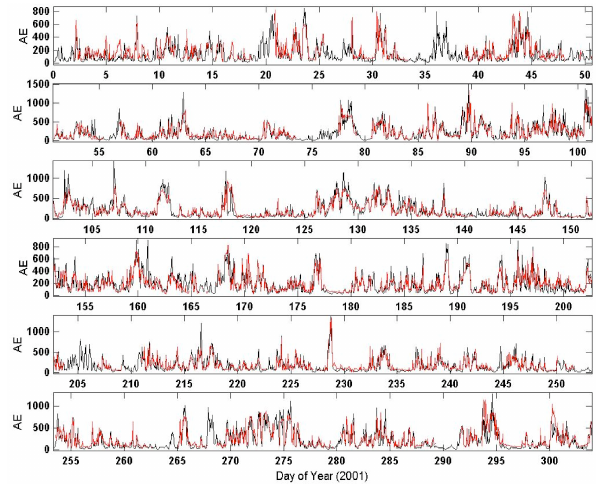
Figure 10. Fig. 10. The AE index values as a function of time in 10 months of 2001 are specified by their corresponding driver states, in ac- cordance with the magnetospheric state prescription of Eqs. (5) and (6). Magnetospheric states are specified by the driver and response parameter data obtained in 1970–2000, with V sw (E0), B z (E1), P sw (E0), and B tot (E0) having been localized. The esti- mation error is ± 111.8nT (consistent with Fig. 6b) and correlation factor with the actual data is 0.826. The black line is the actual ob- served AE index and red line is the estimated AE index. The gaps in the red line indicate periods of no solar wind